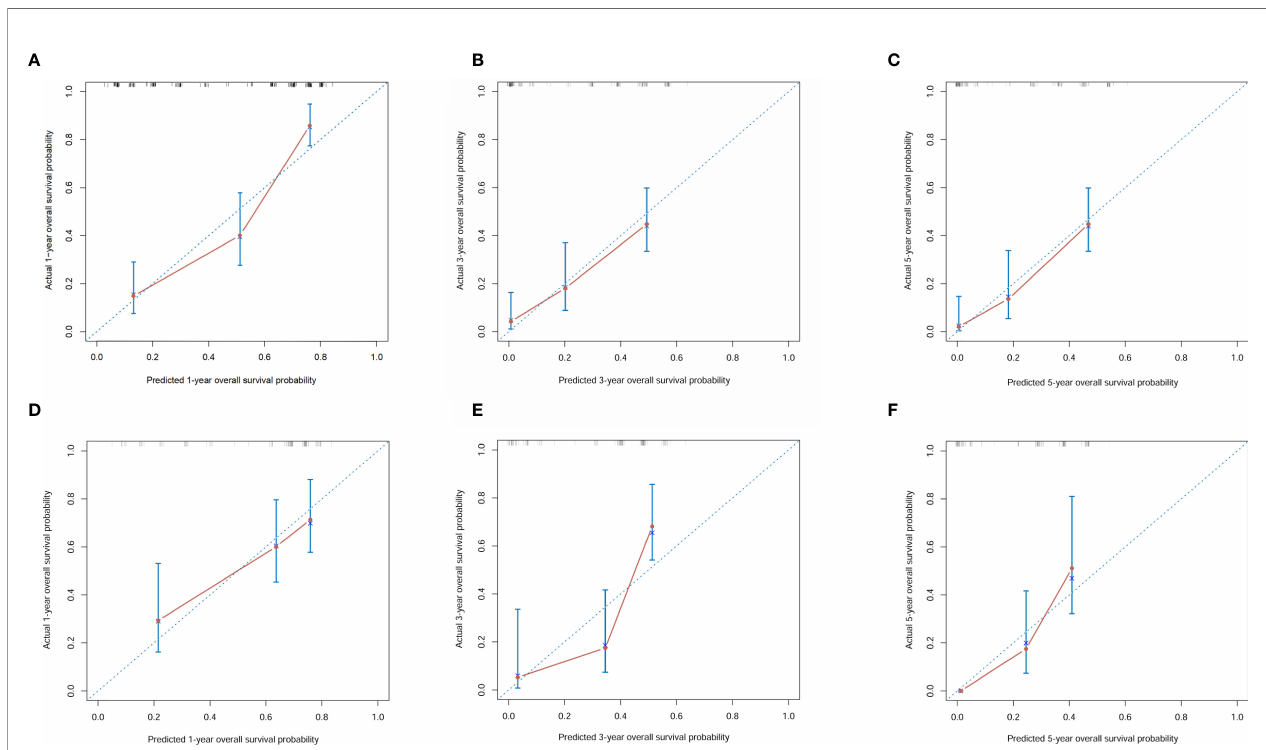
FIGURE 3 | Calibration curves for 1-, 3- and 5-year overall survival of combined hepatocellular carcinoma and cholangiocarcinoma patients in the training cohort and validation cohort. (A) Calibration curves for 1-year overall survival of combined hepatocellular carcinoma and cholangiocarcinoma patients in the training cohort; (B) Calibration curves for 3-year overall survival of combined hepatocellular carcinoma and cholangiocarcinoma patients in the training cohort; (C) Calibration curves for 5-year overall survival of combined hepatocellular carcinoma and cholangiocarcinoma patients in the training cohort; (D) Calibration curves for 1-year overall survival of combined hepatocellular carcinoma and cholangiocarcinoma patients in the validation cohort; (E) Calibration curves for 3-year overall survival of combined hepatocellular carcinoma and cholangiocarcinoma patients in the validation cohort; (F) Calibration curves for 5-year overall survival of combined hepatocellular carcinoma and cholangiocarcinoma patients in the validation cohort.